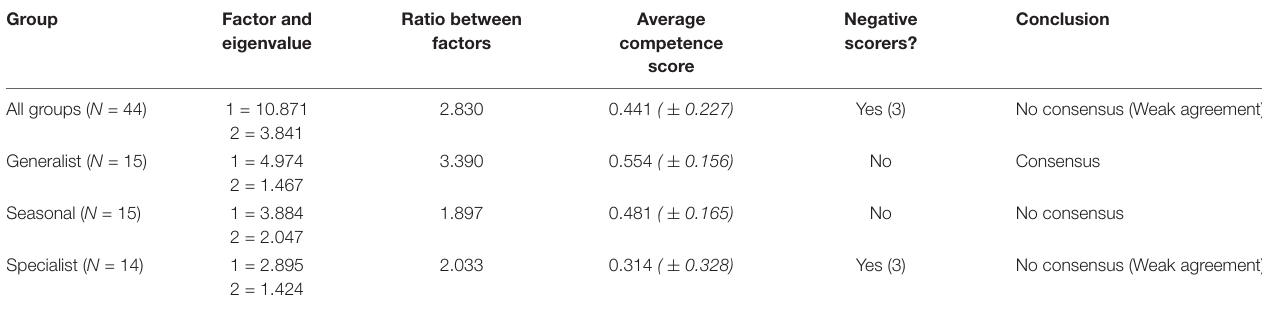
TABLE 2 | Results of the consensus analysis of the dichotomous social-ecological questionnaire (25 items) presented by livelihood subgrouping. Group Factor and eigenvalue